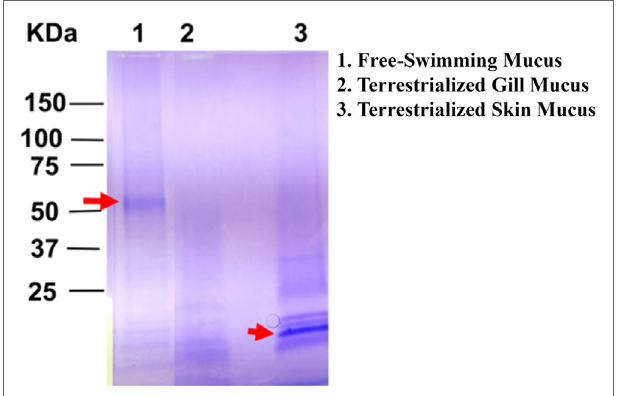
FigUre 2 | Sodium dodecyl sulfate polyacrylamide gel electrophoresis showing unique protein compositions between free-swimming (lane 1), terrestrialized gill mucus (lane 2), and terrestrialized skin mucus samples (lane 3) used for LC/MS-MS proteomic analysis. Red arrows point to high-intensity bands that were excised and analyzed by LC/MS-MS.